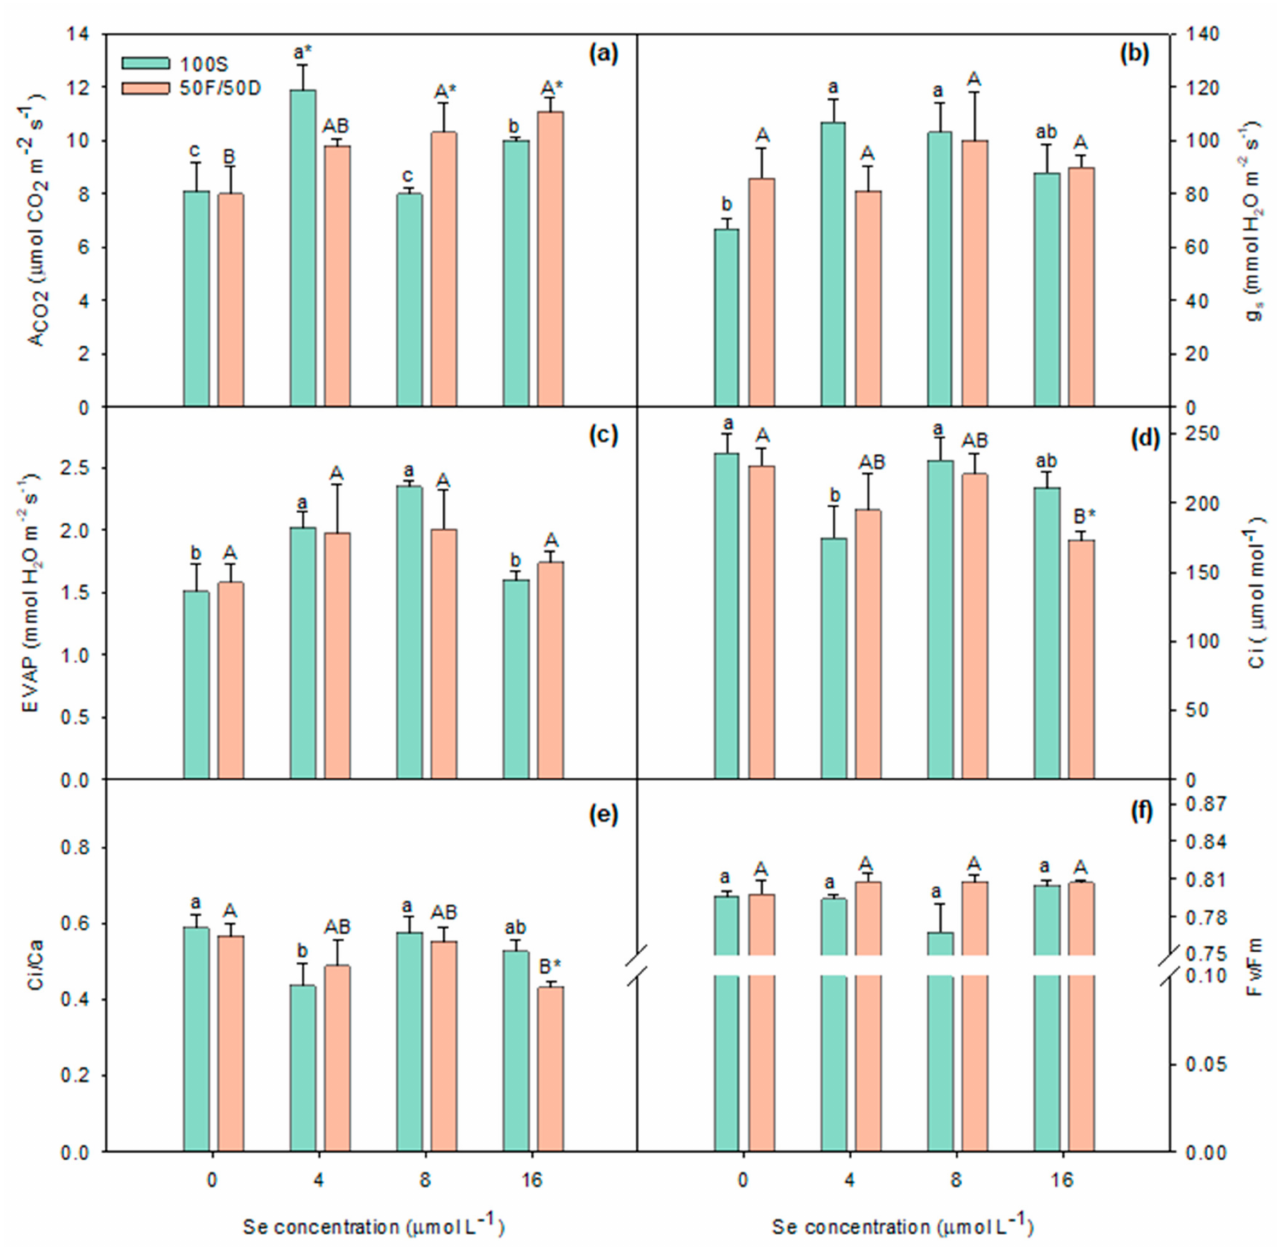
Figure 1. Effects of different selenium concentrations (0, 4, 8, and 16 µ moles L − 1 ) and two types of irrigation water (100S or 50F/50D) on: ( a ) net CO 2 assimilation rate (A CO2 ); ( b ) stomatal conductance (g s ); ( c ) transpiration rate (EVAP); ( d ) internal CO 2 concentration (Ci); ( e ) the internal CO 2 concen- tration/ambient CO 2 ratio (Ci/Ca); and ( f ) maximum potential quantum efficiency of photosystem II (Fv/Fm) in lettuce. The data are presented as the treatment means ( n = 6). Different lower-case letters indicate significant ( p ≤ 0.05) differences between different dosages of selenium combined with the 100S treatment, and different capital letters indicate significant ( p ≤ 0.05) differences between different dosages of selenium combined with the 50F/50D treatment. * denotes significant differences ( p ≤ 0.05) between plants submitted to 100S treatment and those irrigated with 50F/50D for the same Se